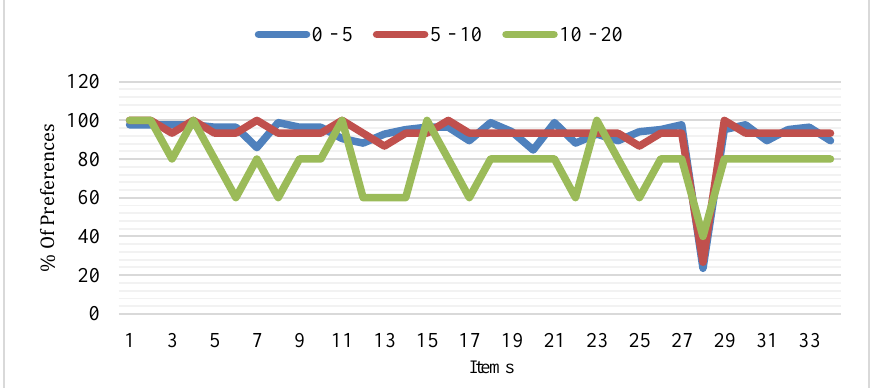
Fig. 5. Preferences of the different items related to the evaluation of the training course in EP by years of teaching